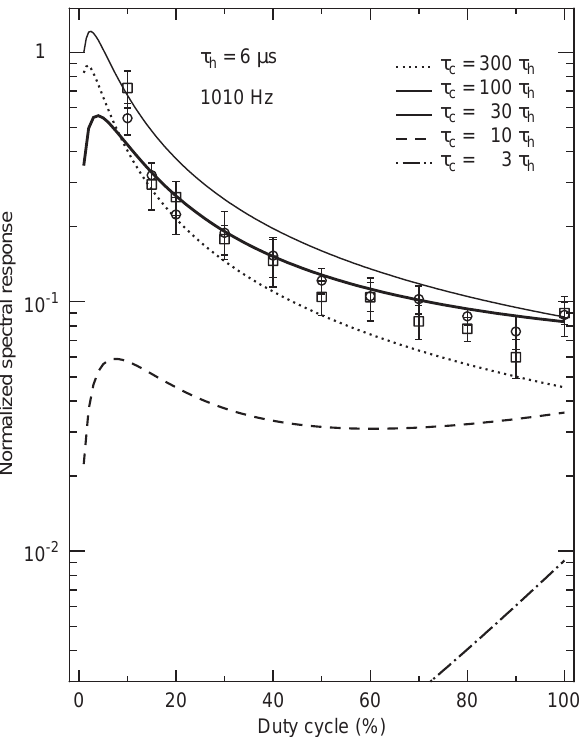
Fig. 12. Theoretical estimates of the normalised spectral response at 1010 Hz plotted for a heating time constant of 6 l s and a range of five cooling time constants. The square and round markers, with their associated error bars, represent the experimentally measured ‘R’ and ‘L’ wave normalised spectral responses respectively